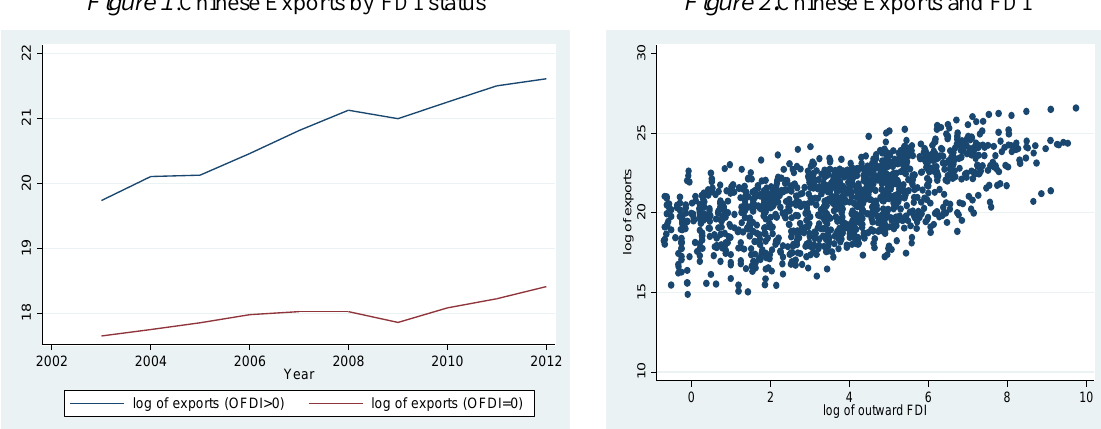
Figure 1 .Chinese Exports by FDI status Figure 2. Chinese Exports and